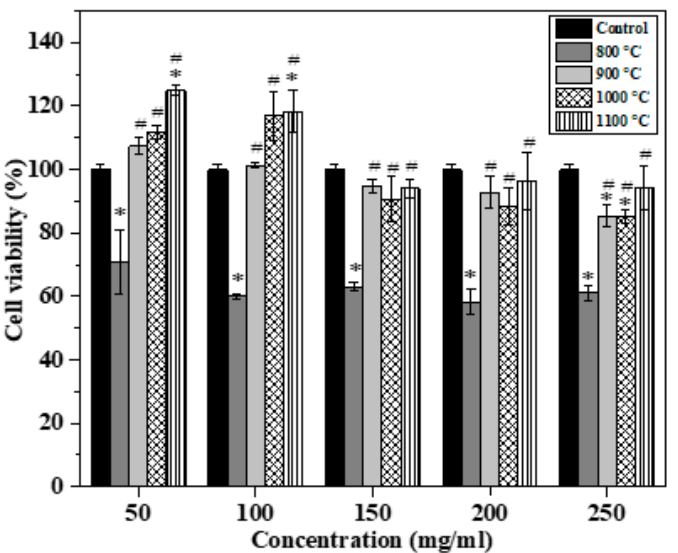
Figure 6. MTT assays of β -TCP powders calcined at temperatures of 800, 900, 1000, and 1100 °C (* presents the statistical differences with respect to the control, n = 3, and p < 0.05; # presents the Scheme 800 °C calcined β -TCP powder).